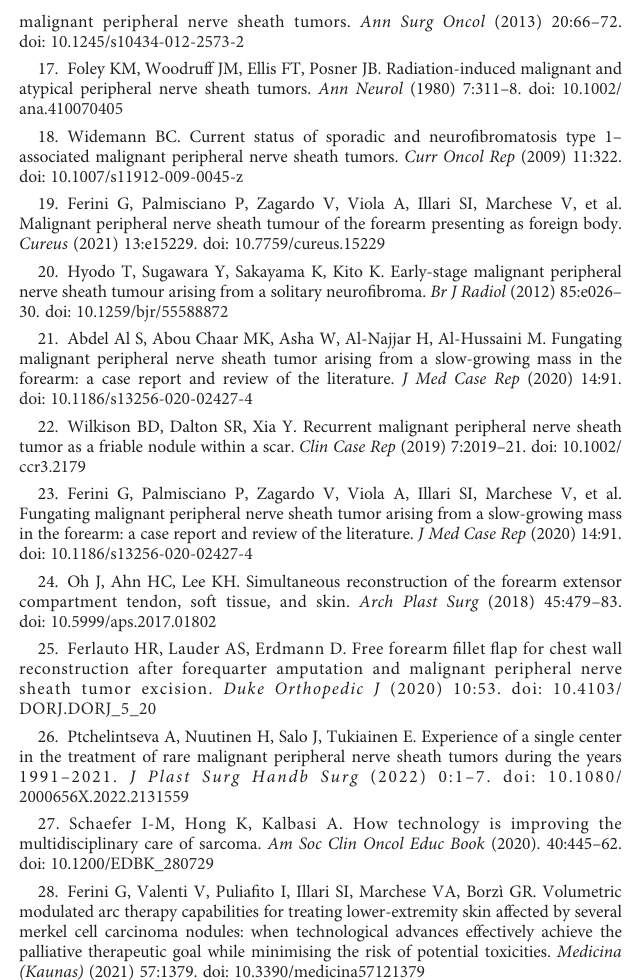
SUPPLEMENTARY FIGURE 1 Flowchart of the patient timeline. CT, computed tomography; MRI, magnetic resonance imaging; IGRT, image-guided radiotherapy; VMAT, volumetric modulated arc